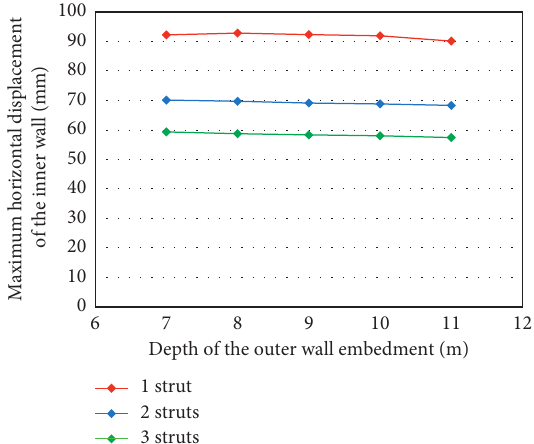
Figure 10: Relationship between the depth of the outer wall embedment and the maximum horizontal displacement of the inner